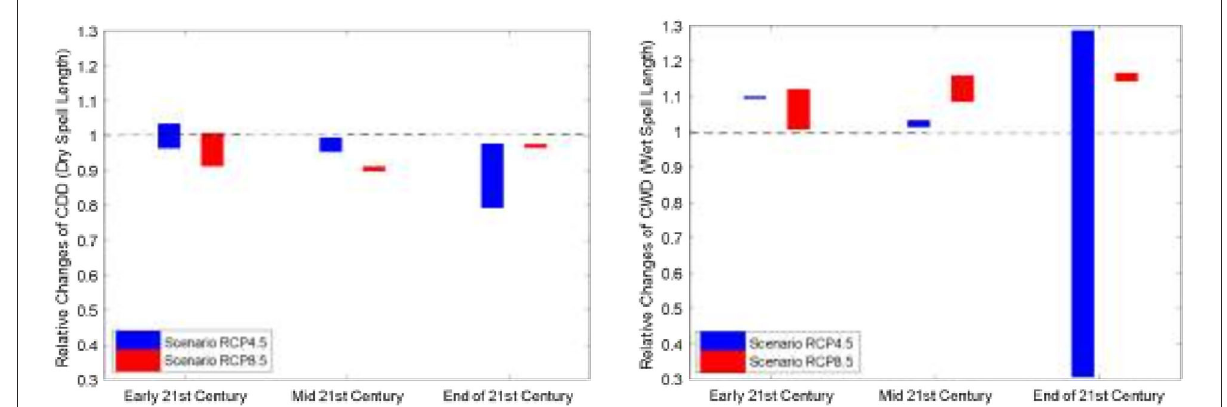
FIGURE4 Relative changes of dry spells (left panel) and wet spells (right panel) for the early 21st century (2011–2040), mid-21st century (2041–2070) and end of 21stcentury (2071–2100) for both RCP4.5 and RCP8.5 downscaled projection at Kota Kinabalu. The dotted line indicates no changes between the future and the historical period.